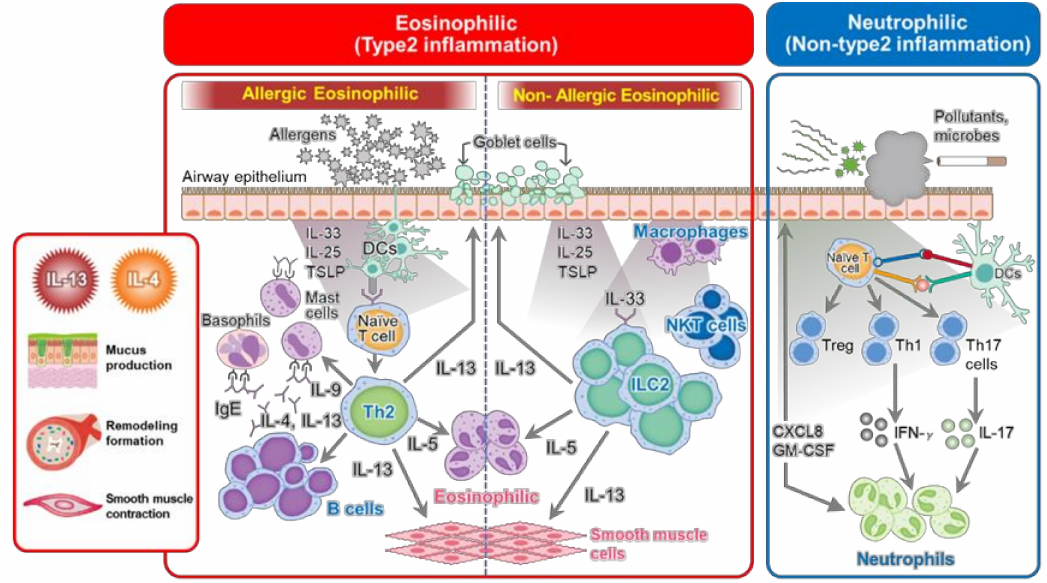
Figure 3. Schematic of the diverse signaling pathways determining bronchial asthma onset and